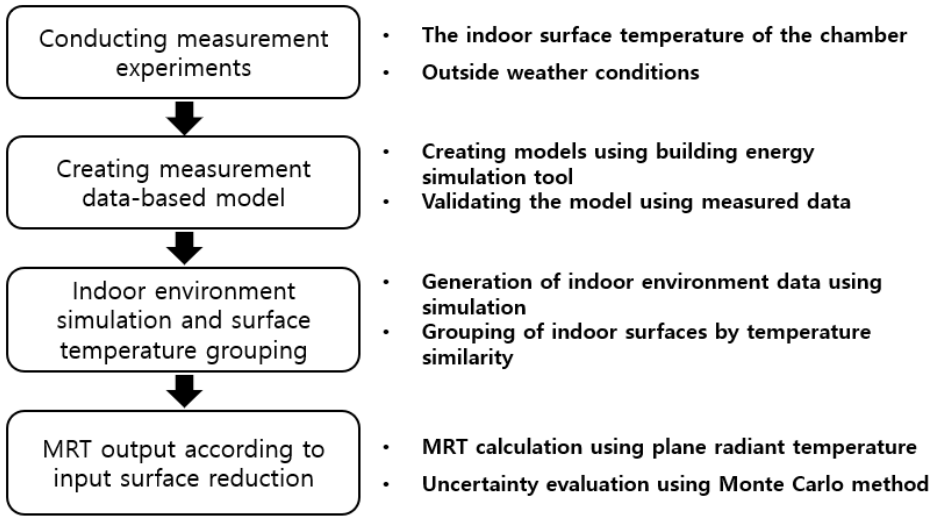
Figure 1. Flowchart of the research.